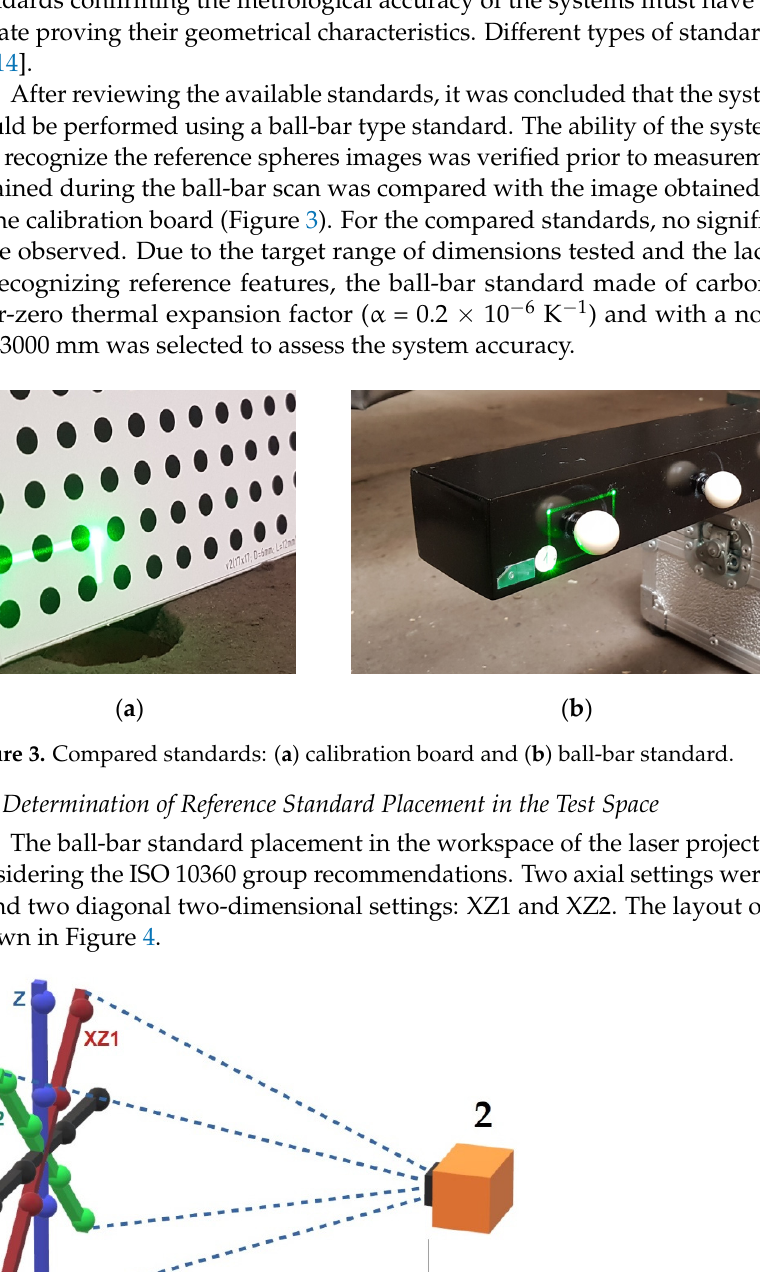
( b ) Figure 2. The tested system: ( a ) galvanometer Scanning System and ( b ) experimental setup. Table 1. Technical specification of the tested device [13]. Parameter